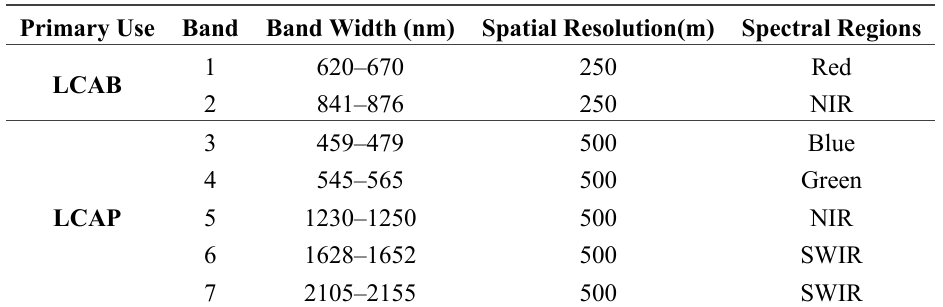
Table 1. Characteristics of the MODIS bands used in the present study. NIR = Near infrared; SWIR = Shortwave infrared; LCAB = Land/Cloud/Aerosol Boundaries; and LCAP = Land/Cloud/Aerosol